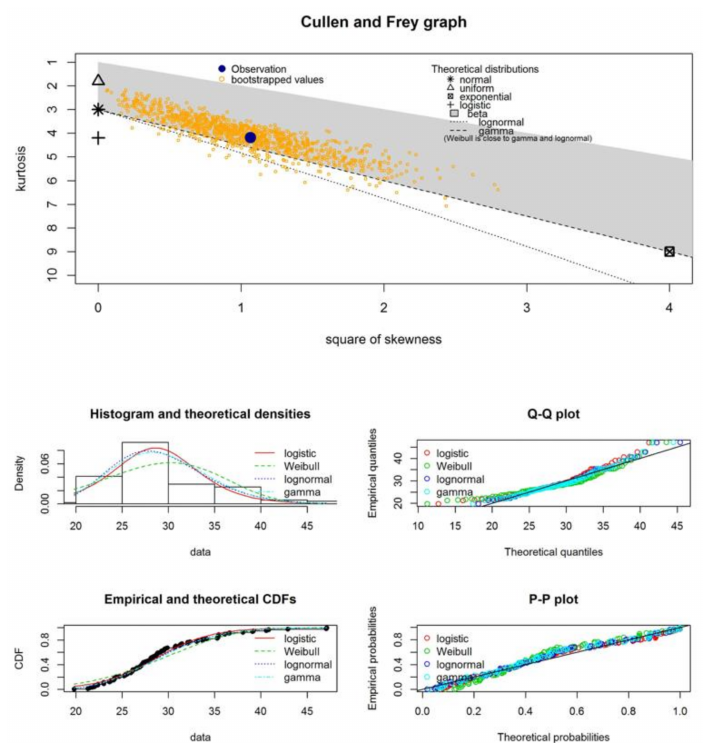
Figure A5. Statistical evaluation of nonwoven samples modified with carbon-based functional coating: ( Top ) Cullen and Frey graph, and ( Bottom ) Probability density plot, cumulative distribution function, Q–Q plot, and P–P plot.